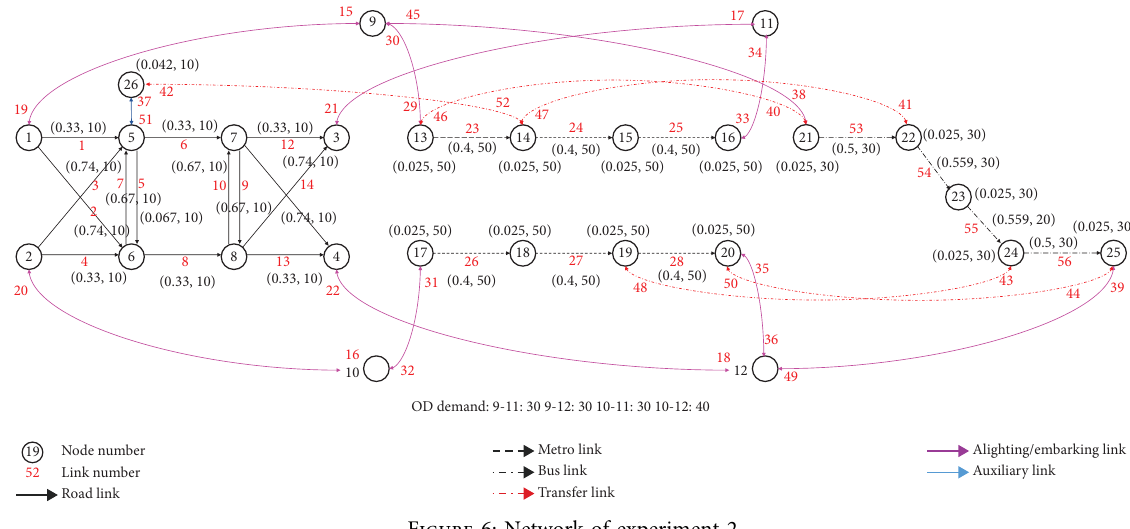
Figure 6: Network of experiment